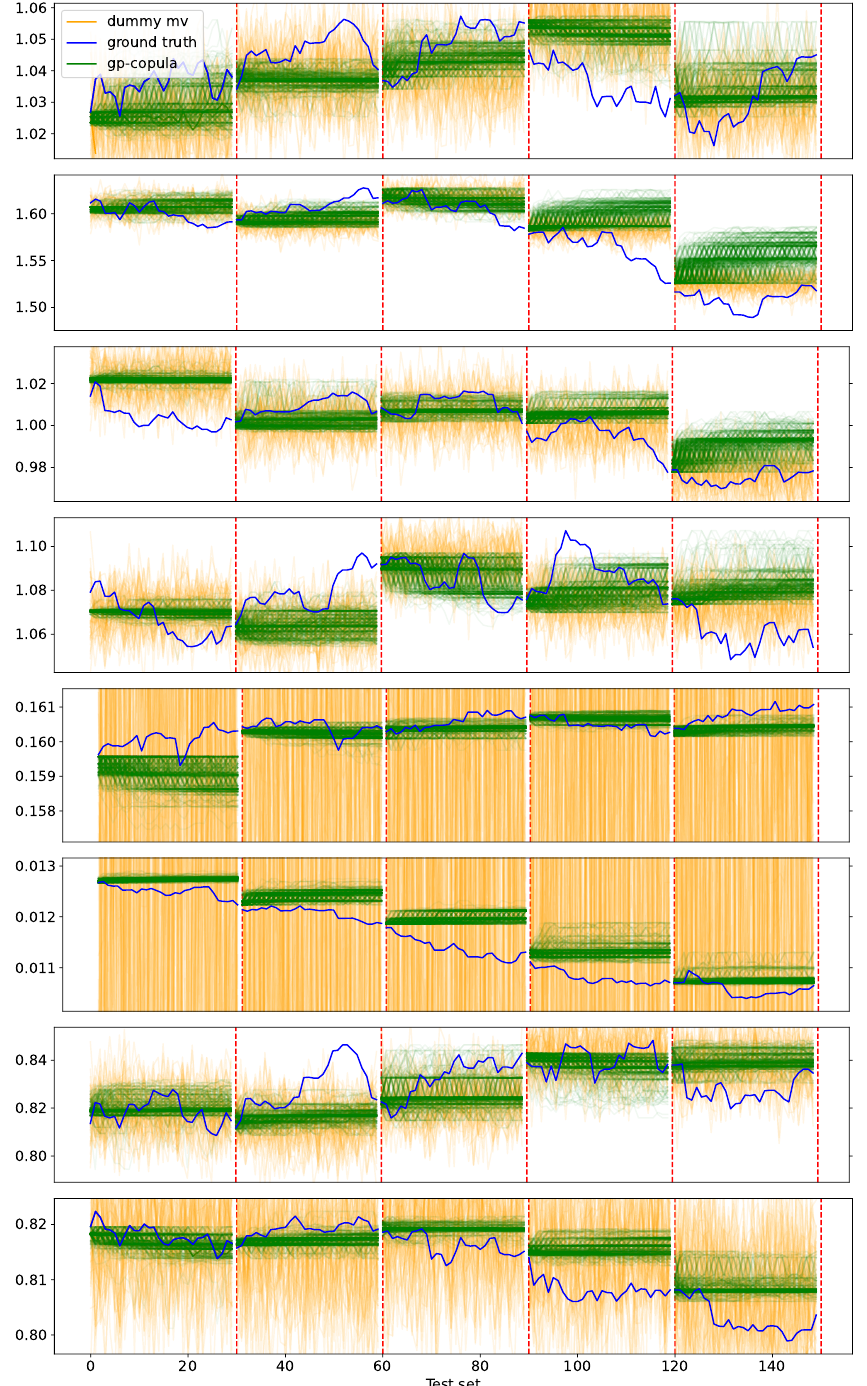
Figure A1. This figure presents the sample forecasts from GP-copula for exchange-rate dataset test set. The dataset has eight dimensions and the test set consists of five batches with 30 time steps. Each subfigure corresponds to one of the data dimensions, presented in original order from the top to bottom. We used 400 samples for visualization of each forecast